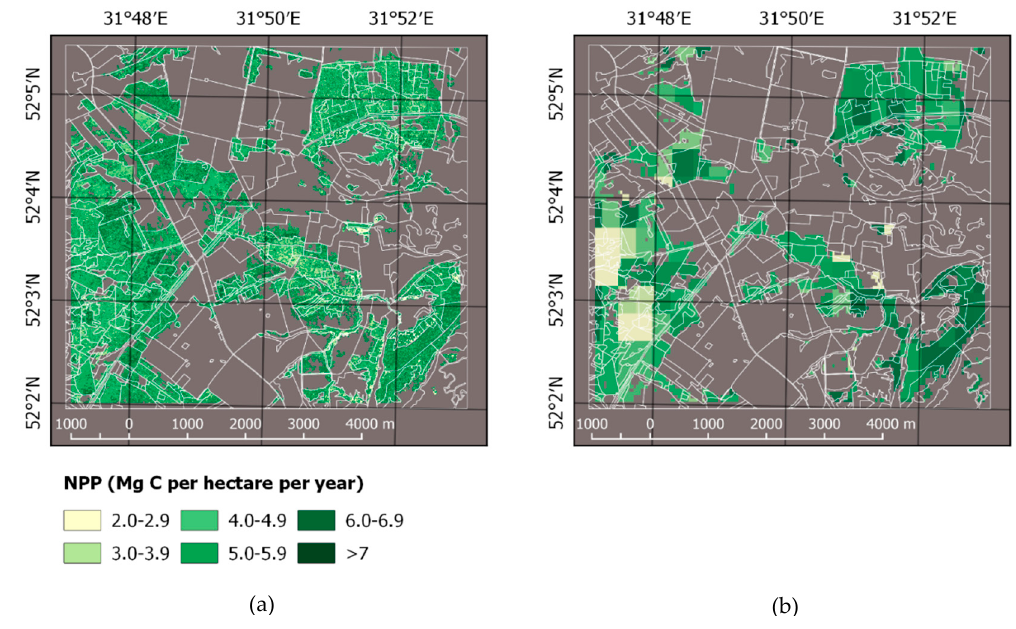
Figure 7. Spatial distribution of forest net primary production (NPP): ( a ) based on SPOT 6 classification for 2015; ( b ) according to Lesiv et al. [6].